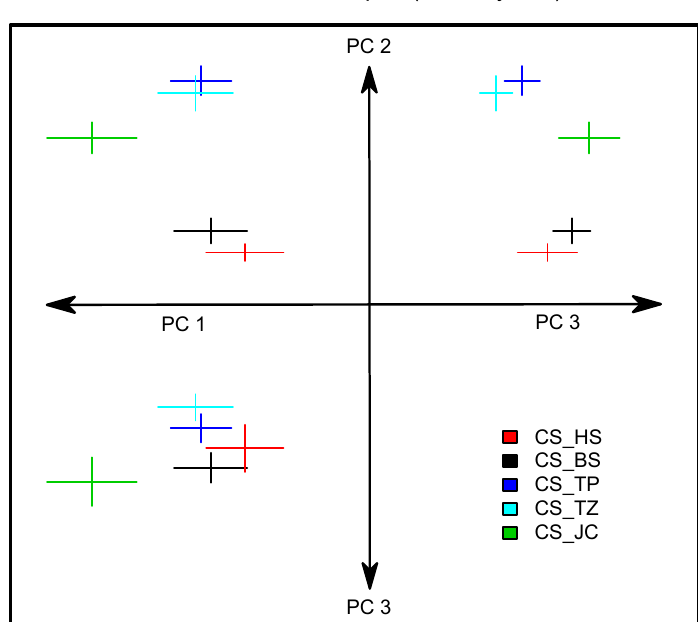
Figure 2. The CS sub-strains can be separated into three groups according to their overall behavior in Buridan’s paradigm. A PCA was performed over the 12 measured variables capturing the flies’ locomotion. The three first principal components are plotted against each other: from the center of the axes; PC1 to the left, PC2 up and PC3 down and to the right. Since units are arbitrary, they were not indicated. For each genotype, we represent the mean and standard error of the mean for the different PCs as a colored cross (data from the two replicates were pooled). The three groups are best visualized separately on the PC2-PC3 plot (upper-right), while PC2 is sufficient to separate the three groups statistically (see text). Sample size for each group is